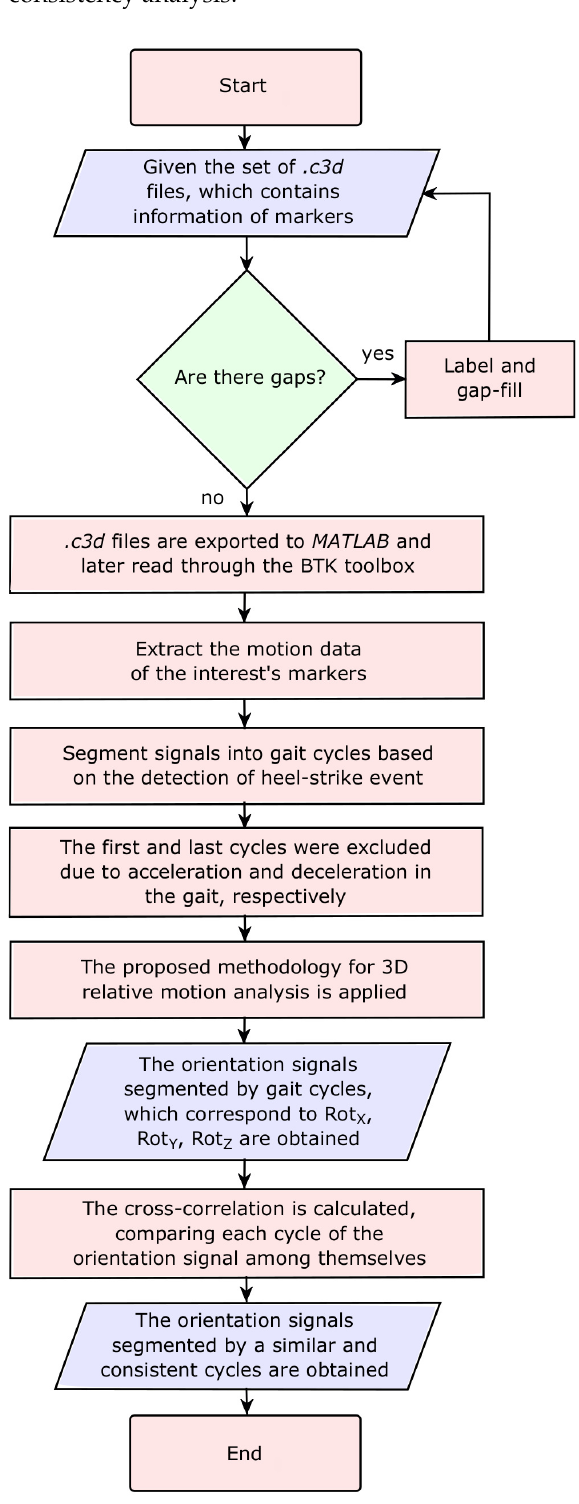
Figure 6. Flowchart of the data processing and